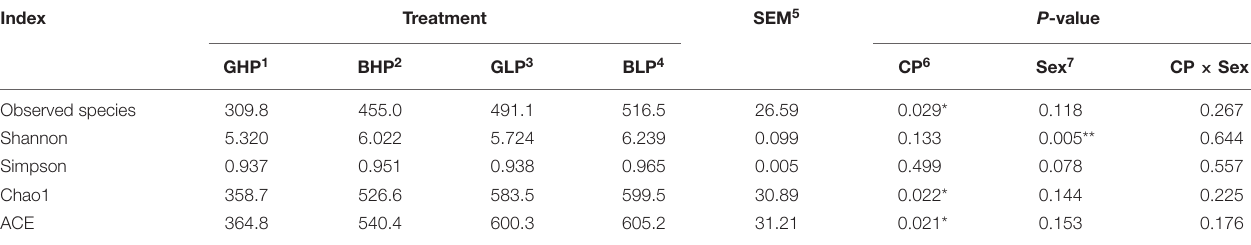
TABLE 1 | Number of observed species, richness and Alpha diversity indices in the colon content samples from each group. Index Treatment